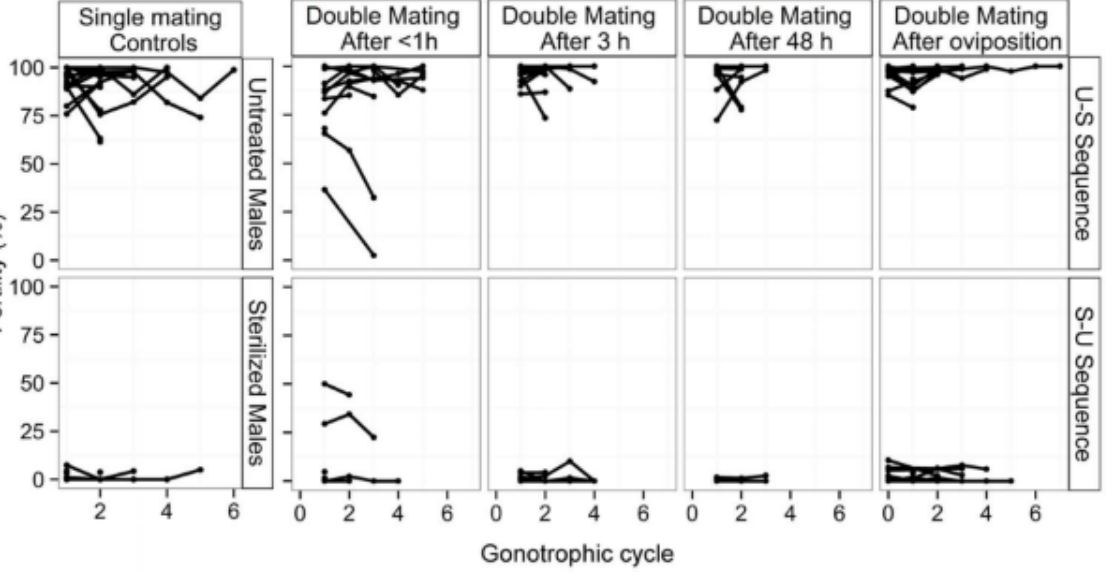
Figure 7. Fertility of female Ae. albopictus mated once with an untreated or sterilized male, or twice at various interval of time with males in untreated-sterilized or sterilized-untreated mating sequences. Individual fertility of females over multiple gonotrophic cycles [305].